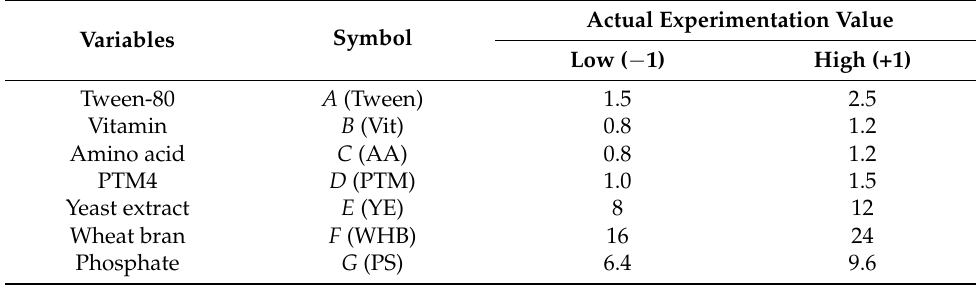
Table 5. Factors and their levels examined in the